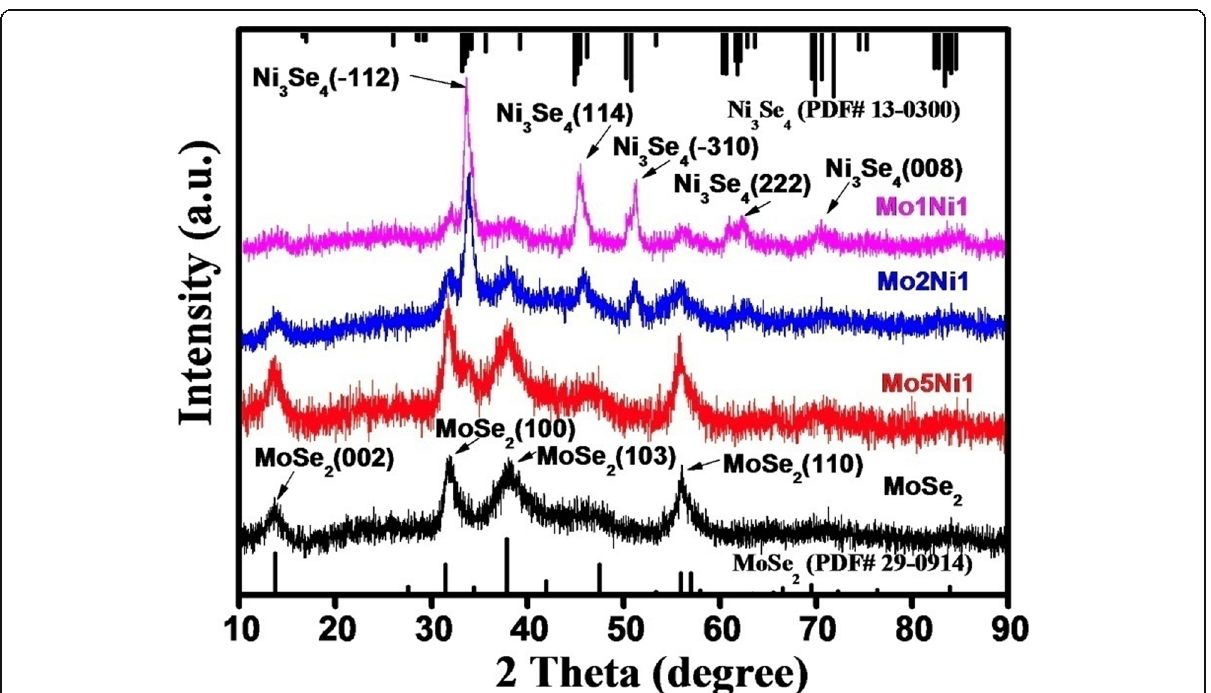
Fig. 2 XRD patterns of pure MoSe 2 and MoSe 2 – Ni 3 Se 4 hybrid samples with different Mo:Ni ratios. Reference patterns of bulk MoSe 2 and Ni 3 Se 4 are also